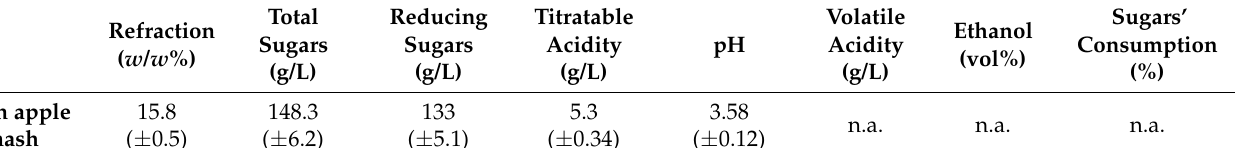
Table 1. The main enological parameters of fresh and fermented apple